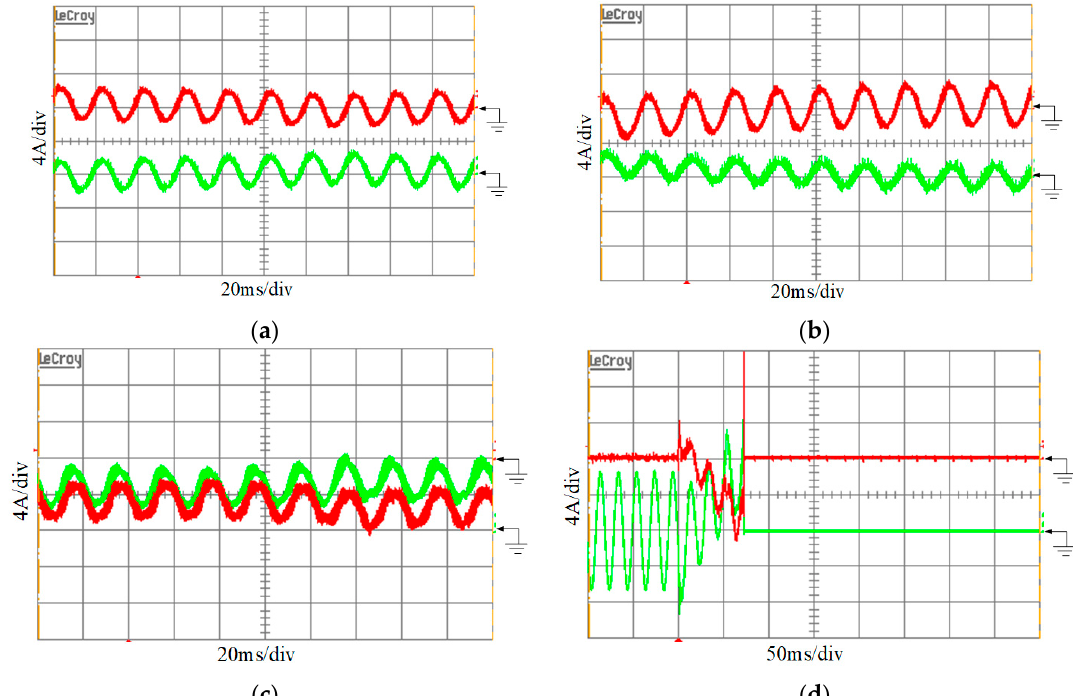
Figure 7. Comparison of average and maximum current-sharing errors by using droop-only-method and TPM. ( a ) Average current-sharing error. ( b ) Maximum current-sharing error.